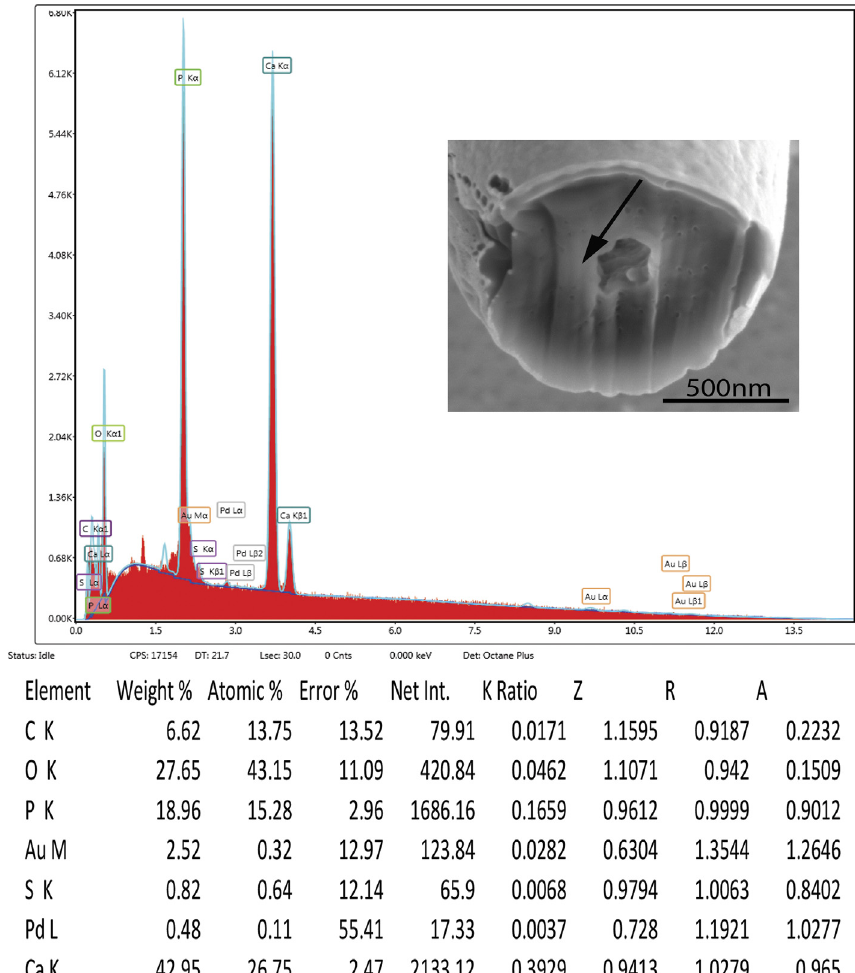
Figure 5. EDAX data for the scan of the center of a cut hook